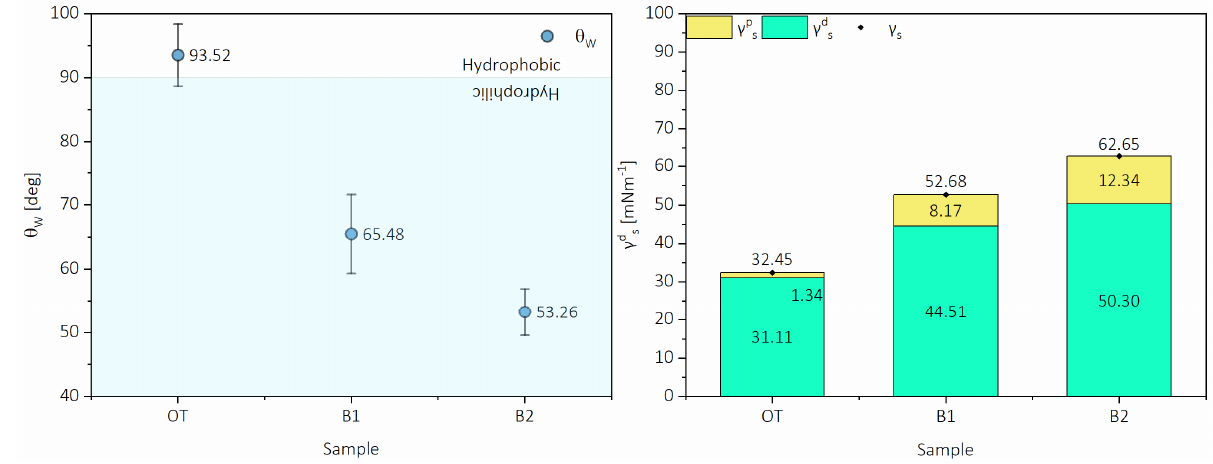
Figure 9. Water contact angle ( θ ) and surface free energy ( γ ) with polar and dispersive components.